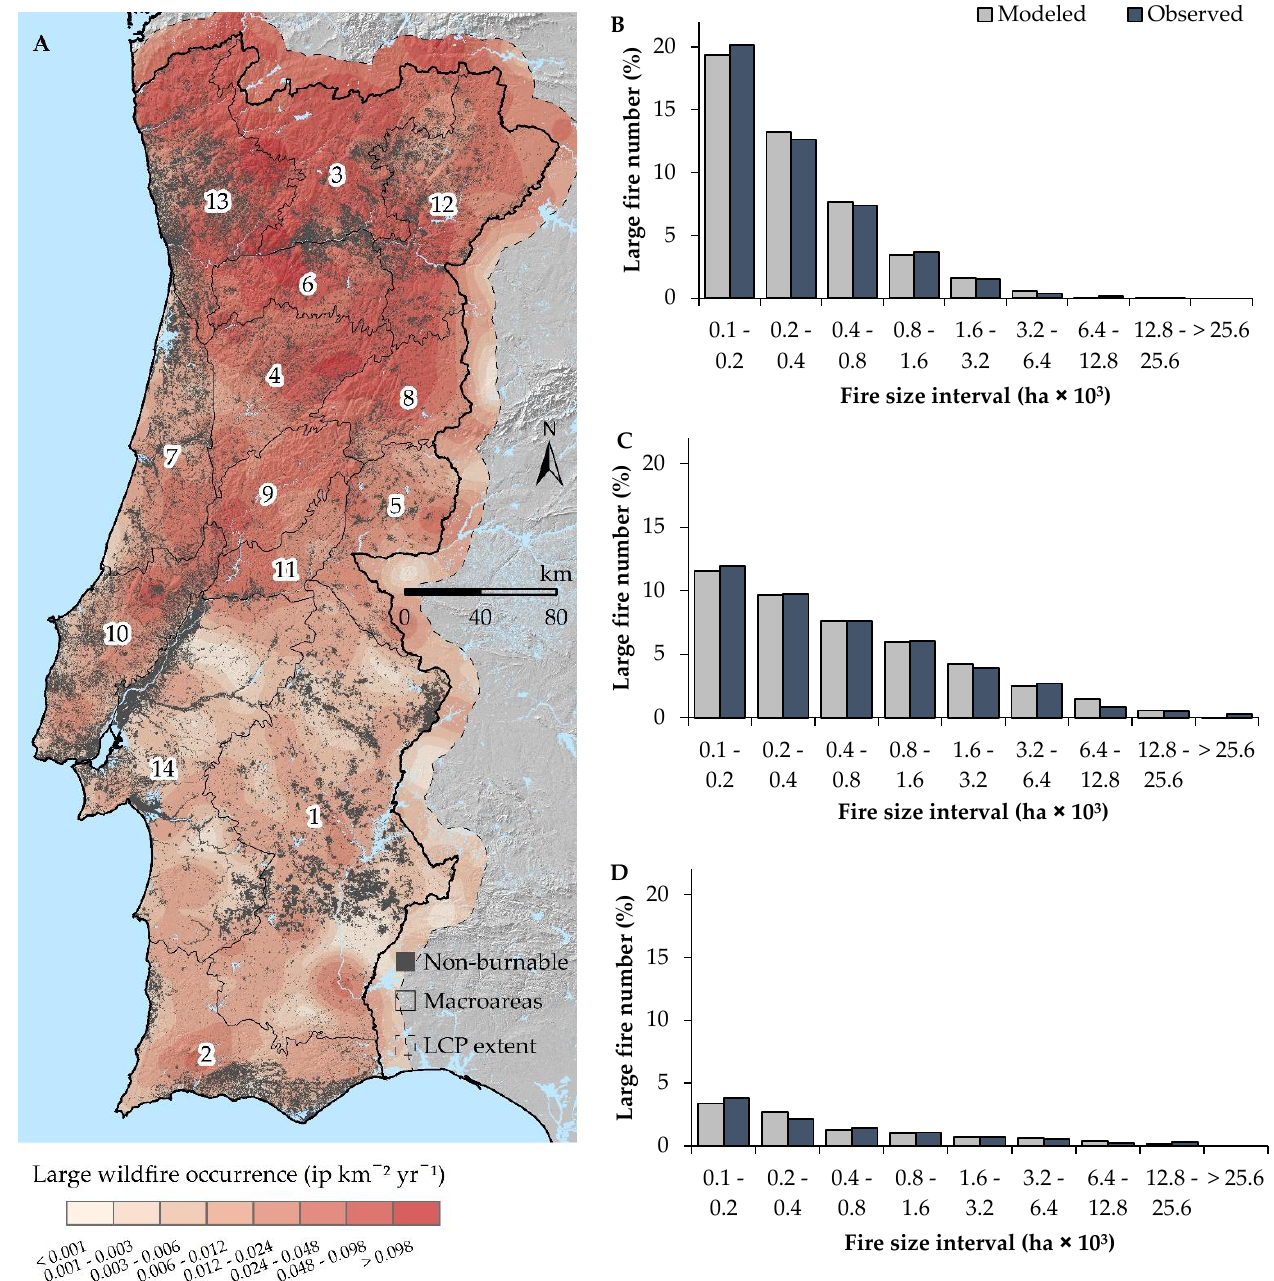
Figure 1. Wildfire simulation modeling macro-areas (n = 14) in Portugal and large historic fire (>100 ha) occurrence ( A ). The wildfire ignitions were distributed based on the historic ignition density grid. In addition, we considered the local extreme fire-weather conditions within each macro-area to model fire spread and behavior (Table 2). Modeled fires replicated historic fire size distributions observed in the northern (( B ); macro-areas 13, 3,12, and 6) central (( C ); macro-areas 7, 4, 8, 9, 5, 11, 5, and 10), and southern (( D ); macro=areas 14, 1, and 2) Portugal. See the probabilistic distribution of modeled fire durations by macro-area in Appendix C. Table 2. Historic wildfire activity within the different macro-areas of Portugal (Figure 1) from 1985 to 2019. We considered a 100-ha large fire threshold to describe the fire activity in the different macro-areas. See macro-area abbreviations in Table 1. We used the annually burned area to determine the number of fire ignitions required to replicate a burned area equiv- alent to 10,000 years per macro-area.